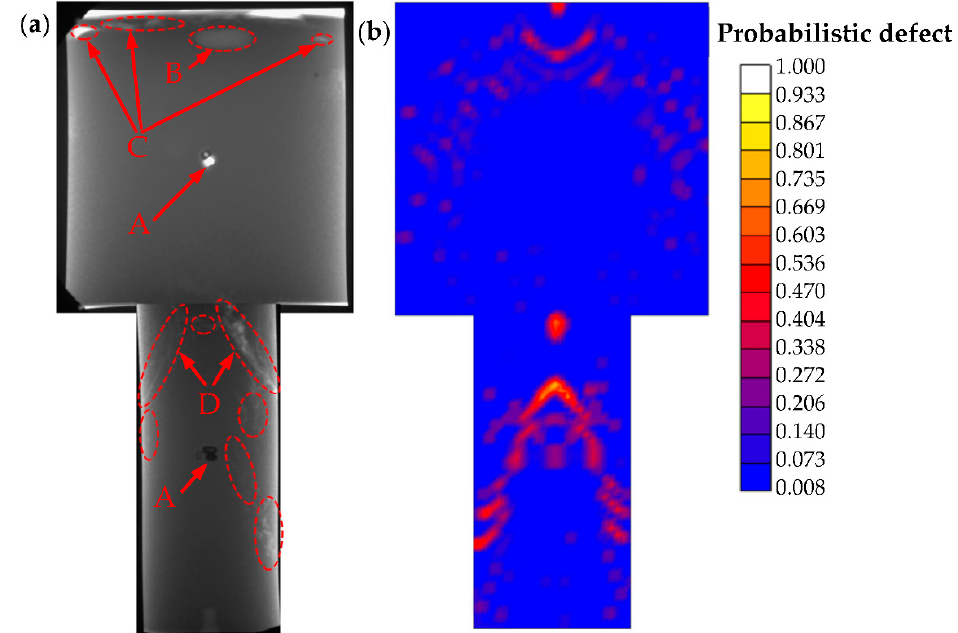
Figure 6. Comparison of ( a ) experimental and ( b ) numerical shrinkage defects of stationary casting.